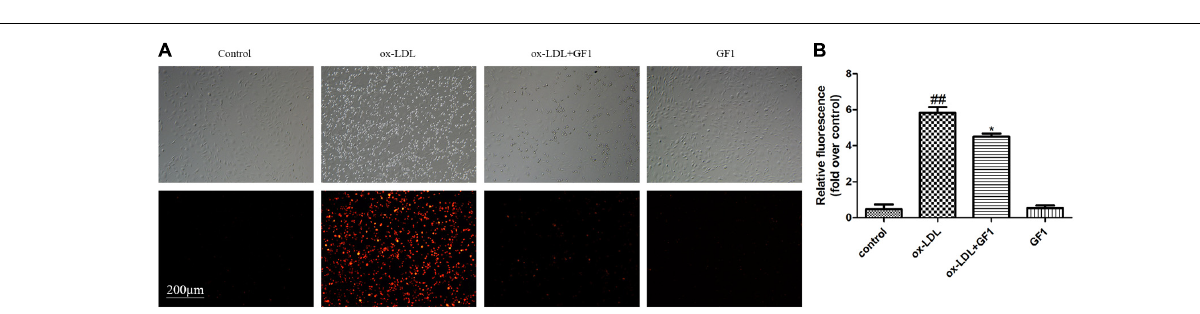
FIGURE 5 | Ginsenoside F1 mitigated the adhesion of THP-1 cells to HUVECs stimulated by ox-LDL. HUVECs were pre-treated with GF1 (16 µ M), followed by treatment with ox-LDL for another 24 h. (A) Representative images of CM-diL labeled THP-1 cells adherent to HUVECs. (B) The quantitative analysis of relative fluorescence of CM-diL labeled THP-1 cells adherent to HUVECs. All of the results are expressed as the mean ± SD of three independent experiments. ## p < 0.01, vs. control group; ∗ p < 0.05, ∗∗ p < 0.01 vs. ox-LDL